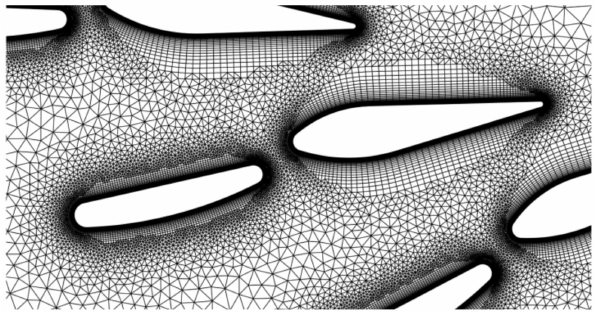
Figure 5. Transition between prismatic and tetrahedral volume cells.